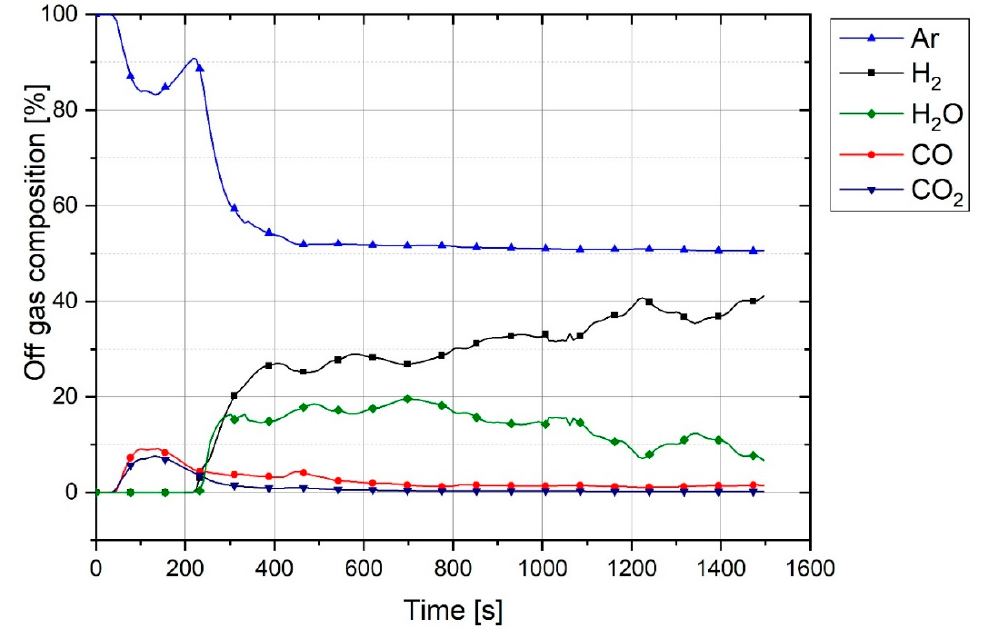
Figure 6. Chemical composition of off-gas from Experiment 1.